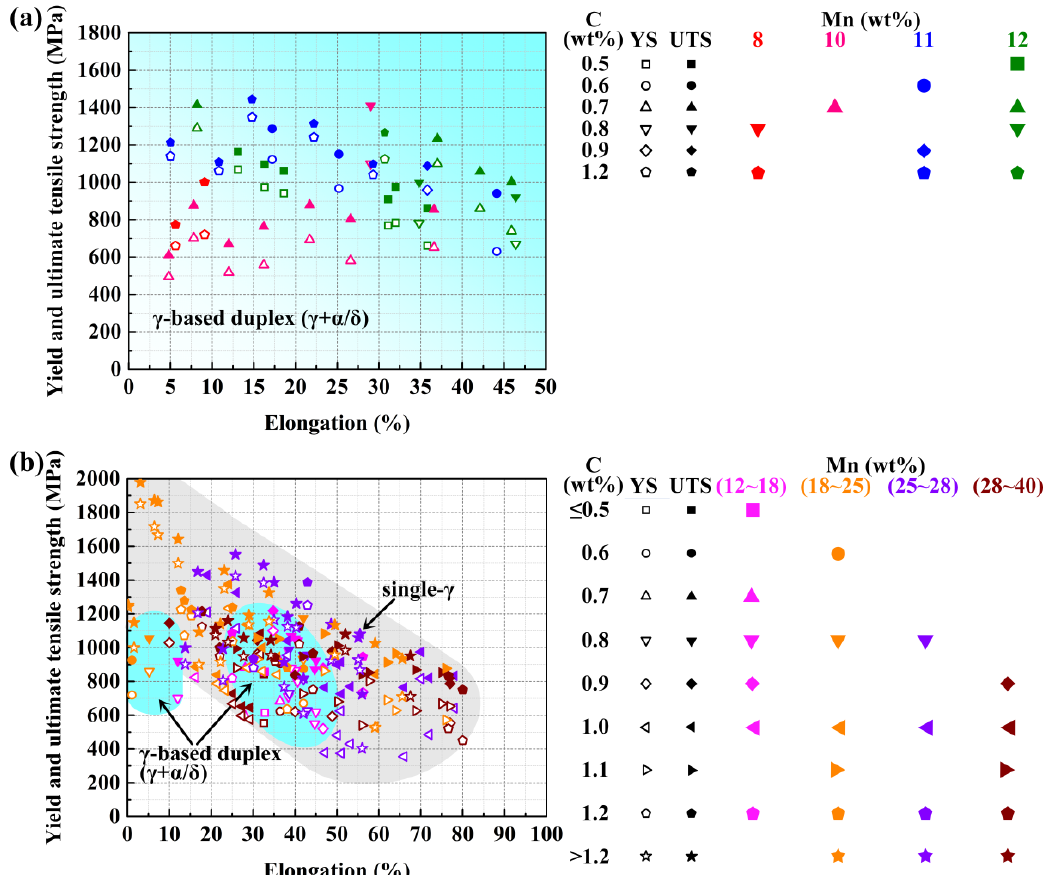
Figure 2. Comparison of room-temperature tensile properties of the present developed ( a ) medi- um-Mn [10,38,40–42,45,46,50,51,53–55,84] and ( b ) high-Mn [3,18,57,58,63,67,69,78,79,83,85,91,100,103,107,109–111,113,116,122,124,127,129,141,143–159] light- weight steels.